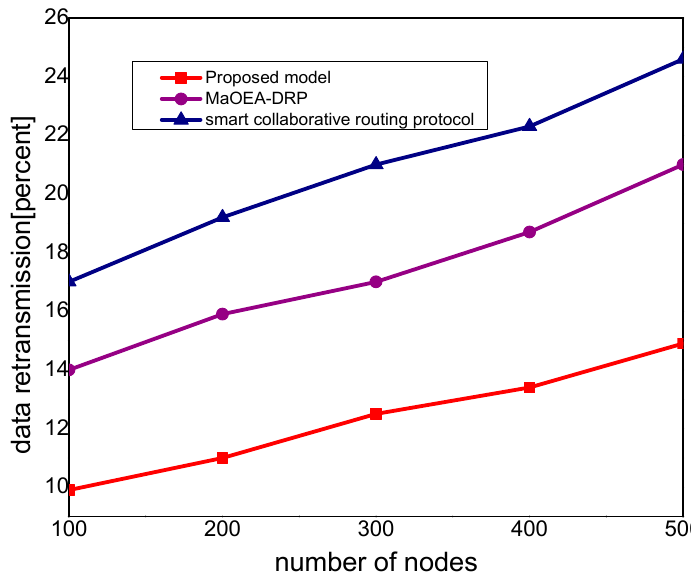
Figure 7. Data retransmission with the number of nodes.